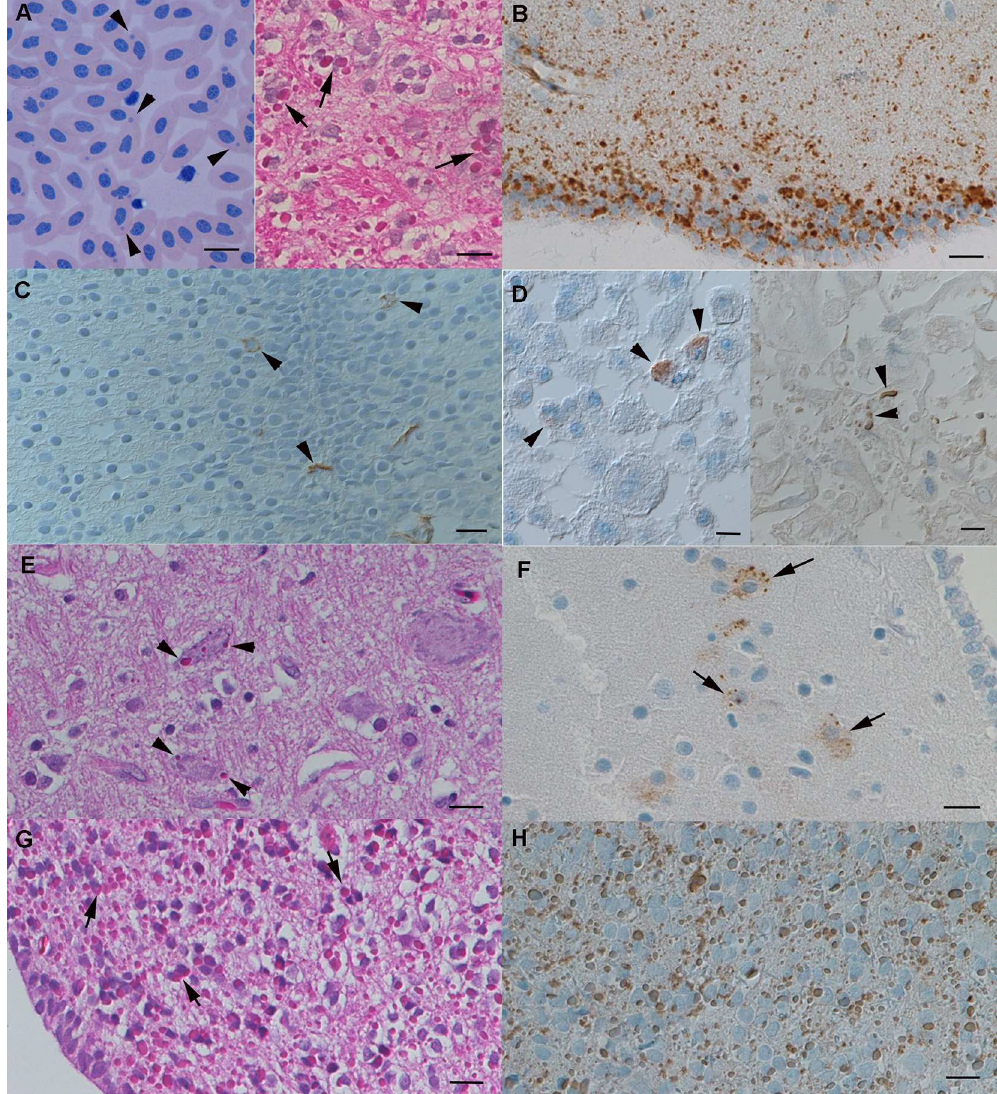
Fig 1. Confirmation of BIBD in parental animals and offspring. A, B . Clutch 1, BIBD-positive mother. A . The characteristic cytoplasmic inclusionbodies(IB; arrows) are present in erythrocytes (left, blood smear, May- Gru¨nwald Giemsa stain) and in cells in tissues (brain). B . Immunohistologyconfirms the presenceof abundant reptarenavirus antigenin all cell types in associationwith the presenceof the IB. C. Clutch 2, embryo (E2.1). A few neuronsin the spinal cord exhibitreptarenaviral antigenin the cytoplasm (arrowheads). D . Clutch 2, embryo (E2.1). Cell pelletfrom a brain cell culture. Left: passage1, right: passage6. There are individual cells expressingviral antigen(arrowheads). E, F. Clutch 3, perinatalabortion(PNA2,2), brain. E . A few individualneuronsexhibitBIBD IBs (arrows). F . Reptarenavirus antigenexpressionis seen in association with inclusionbodiesand dispersedin the cytoplasm (arrows). G, H . Clutch 5, juvenile(J5.4), 8 mo, brain. G . AbundantIB (arrows) are seen within almost all cells. H . Reptarenavirus antigenexpressionis seen in associationwith inclusionbodies.A, E, G: haematoxylin eosin stain; B, D, F, H: HRP method, haematoxylincounterstain. Bars = 10 μ